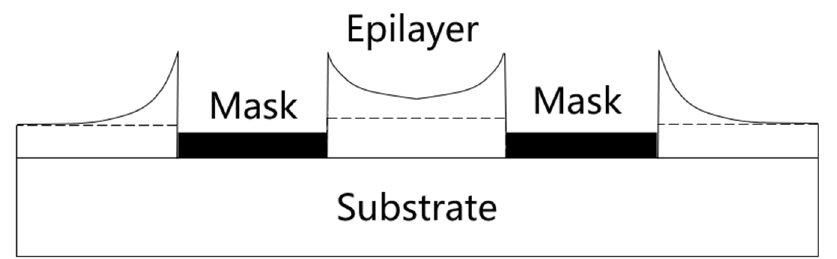
Figure 2. Schematic of the cross-section of the growth-rate enhancement process. The area below the dashed line is the layer thickness grown on the unmasked substrate, and the excess thickness due to GRE is the area above the dashed line.